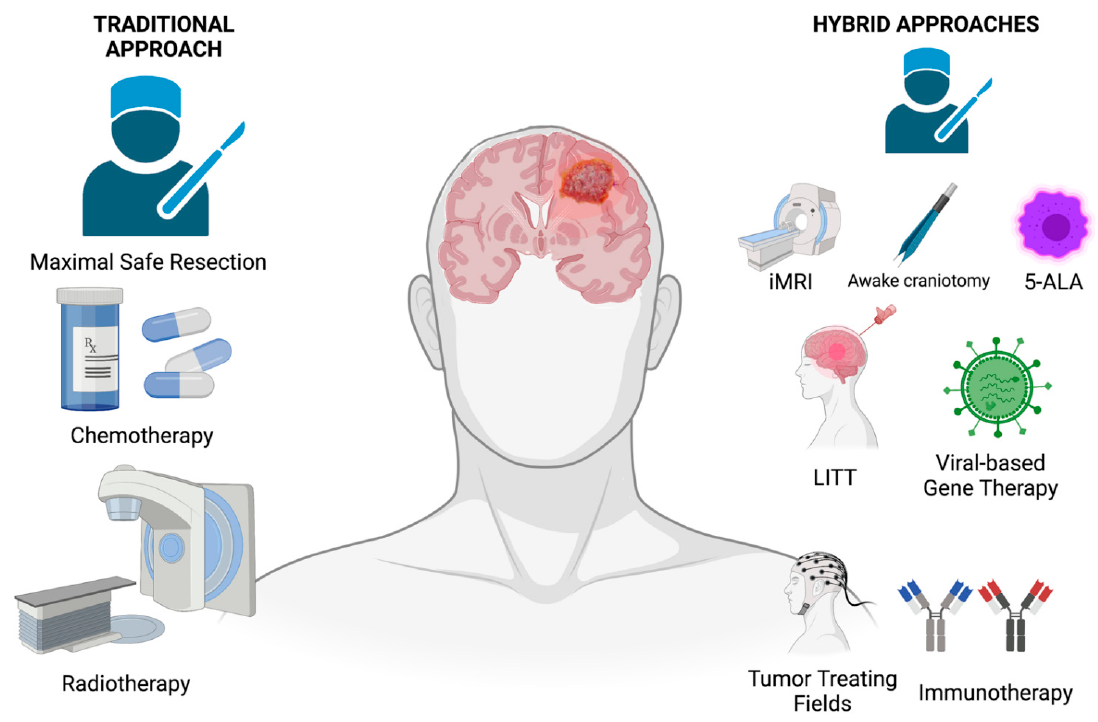
Figure 1. Schematic demonstrating new hybrid approaches for glioblastoma therapy.